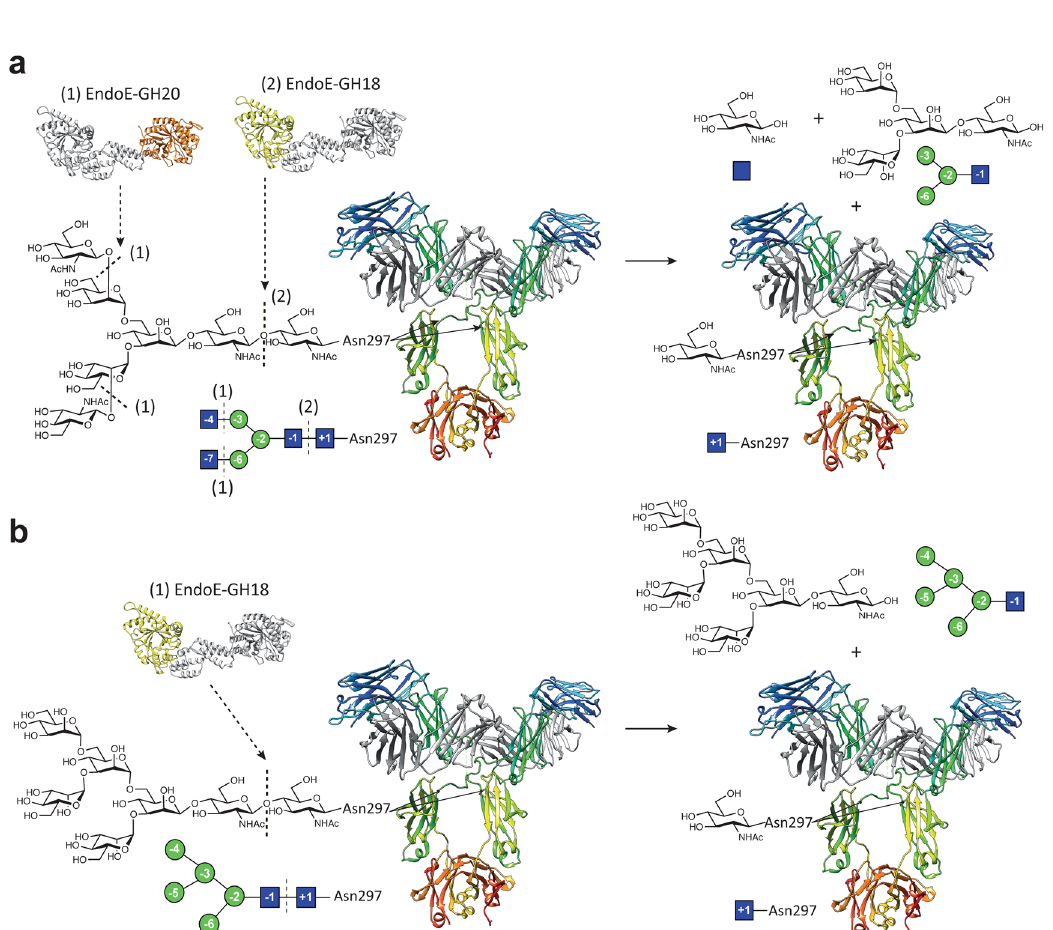
Fig. 10 EndoE model of action. a Schematic representation of CT N -glycan processing by EndoE. In a fi rst step, EndoE-GH20 cleaves the non-reducing terminal GlcNAc residues from the CT N -glycan substrate, generating smaller glycoforms that can be processed by EndoE-GH18. In a later stage, EndoE- GH18 cleaves the chitobiose core of the N -linked glycan, releasing the glycan from the protein substrate. b Schematic representation of HM-type N -glycan processing by EndoE. As EndoE-GH20 has no activity on mannose, EndoE-GH18 is the only domain acting on HM-type N -glycan substrates, directly cleaving the chitobiose core of the N -linked glycan and releasing the glycan from the protein